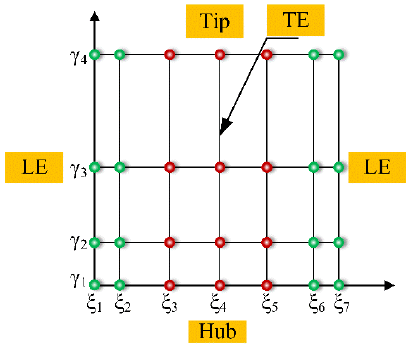
Figure 7. Bezier surface active control